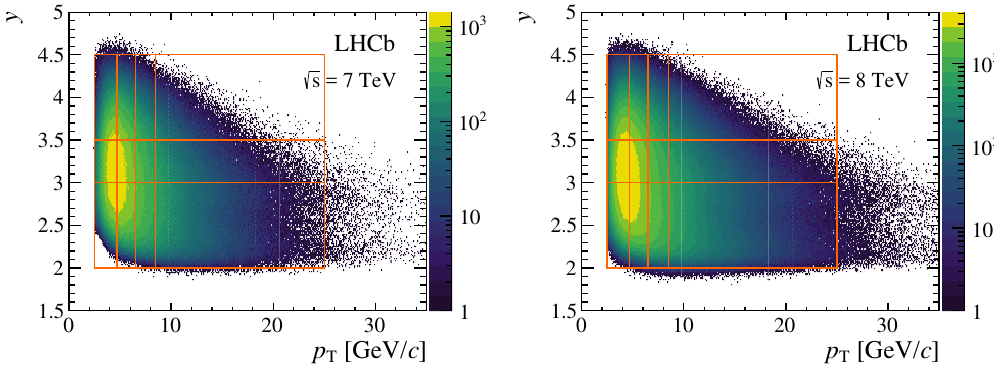
p candidates for the s = 7 and 8 TeV data sets as a function of p T s ) measurement is s